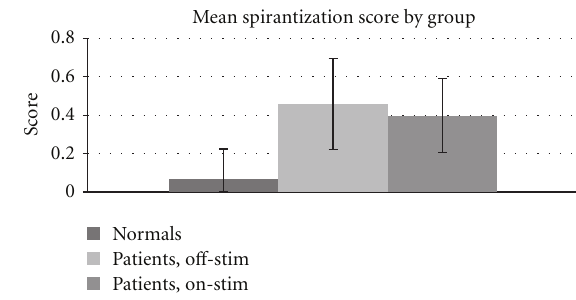
Figure 5: Spirantization score across treatment conditions.